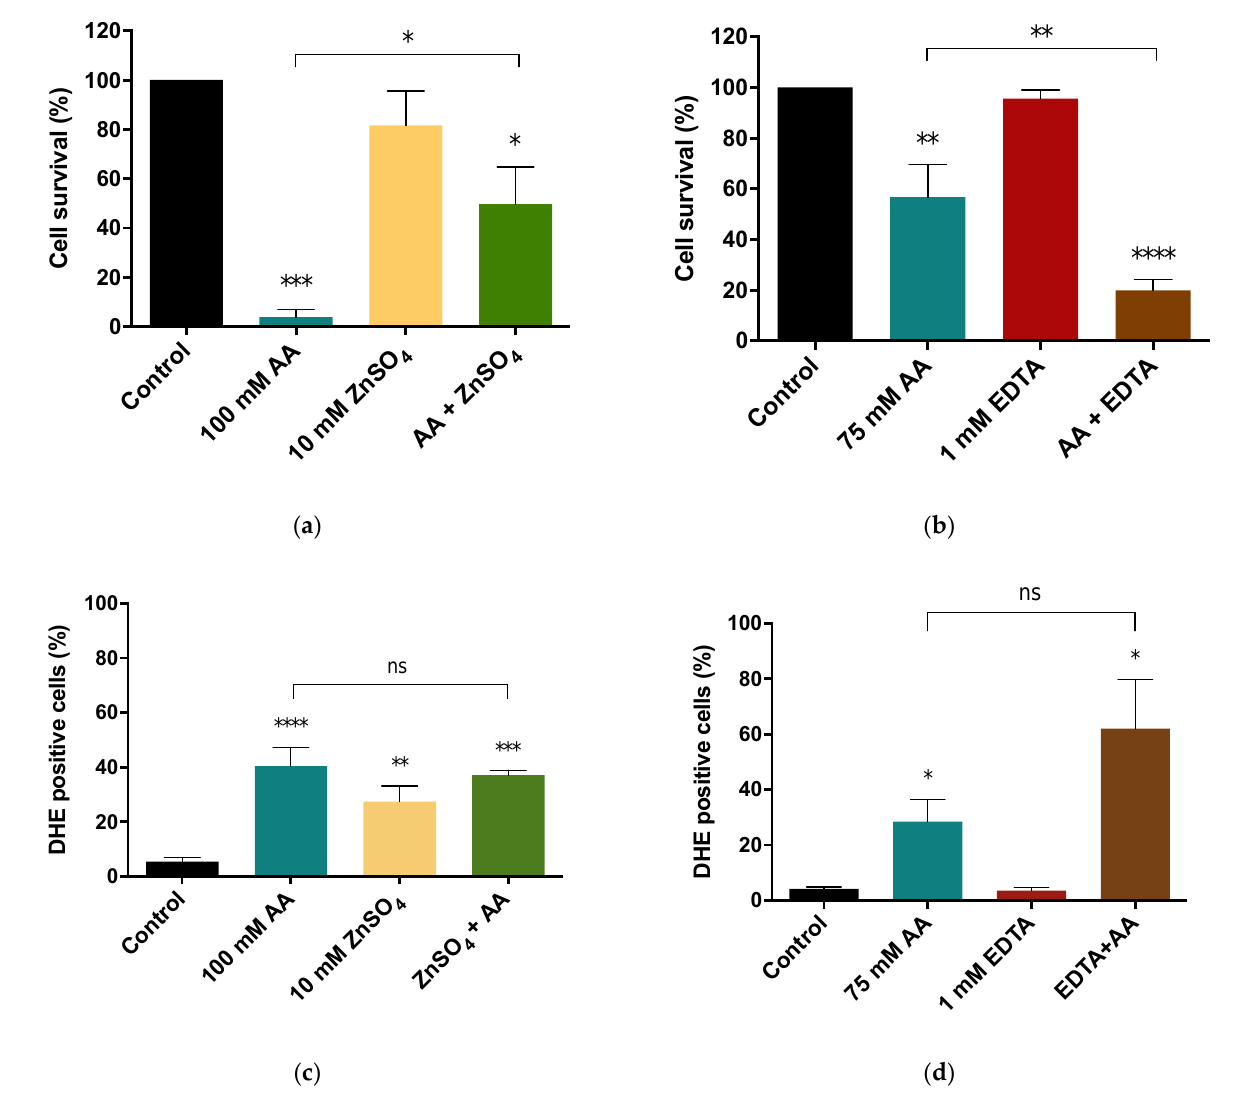
Figure 4. Effect of zinc supplementation ( a ) or limitation ( b ) on AA-induced cell death and cellular superoxide anion accumulation ( c , d ) in S. cerevisiae BY4741 wild-type cells. ( a ) Cells were treated with 10 mM ZnSO 4 , 100 mM AA or co-treated with both for 60 min. ( b ) Cells were pre-treated with and without 1 mM EDTA for 30 min and next treated with 1 mM of EDTA, 75 mM of AA or co-treated with both for 90 min. Cell survival was assessed by c.f.u. counting. ( c ) Quantification of the percentage of DHE-positive stained cells after supplementation with 10 mM ZnSO 4 , 100 mM AA or both for 60 min. ( d ) Quantification of the percentage of cells with DHE-positive staining after pre- treatment with and without 1 mM EDTA for 30 min, followed by treatment with 1 mM of EDTA, 75 mM of AA or both for 90 min. Values are percentages of DHE-positive cells ± SEM of three ( a and b ), five ( c ) and three ( d ) independent experiments. Statistical analysis was performed by one-way ANOVA. * p < 0.05, ** p < 0.01, *** p < 0.001, **** p ˂ 0.0001 in comparison with the control, or between indicated conditions. Non-significant values are represented as ns .